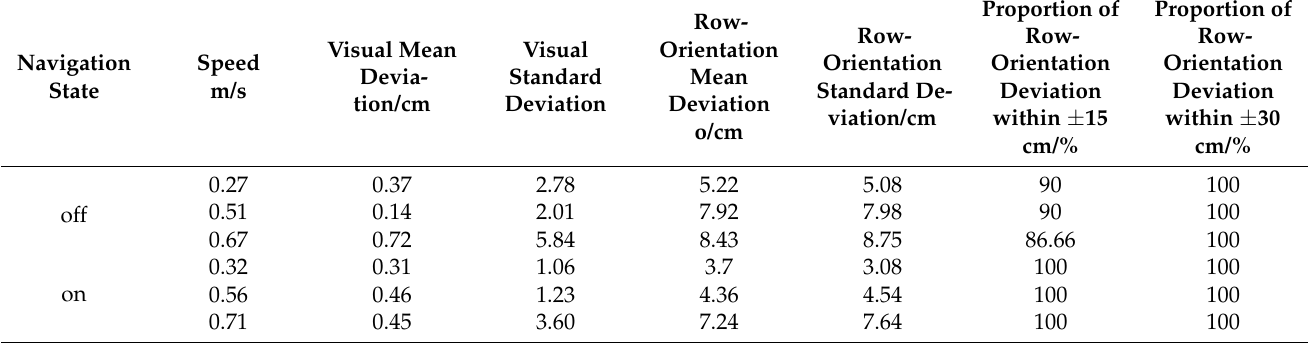
Table 3. Field Table 3. Field tests.